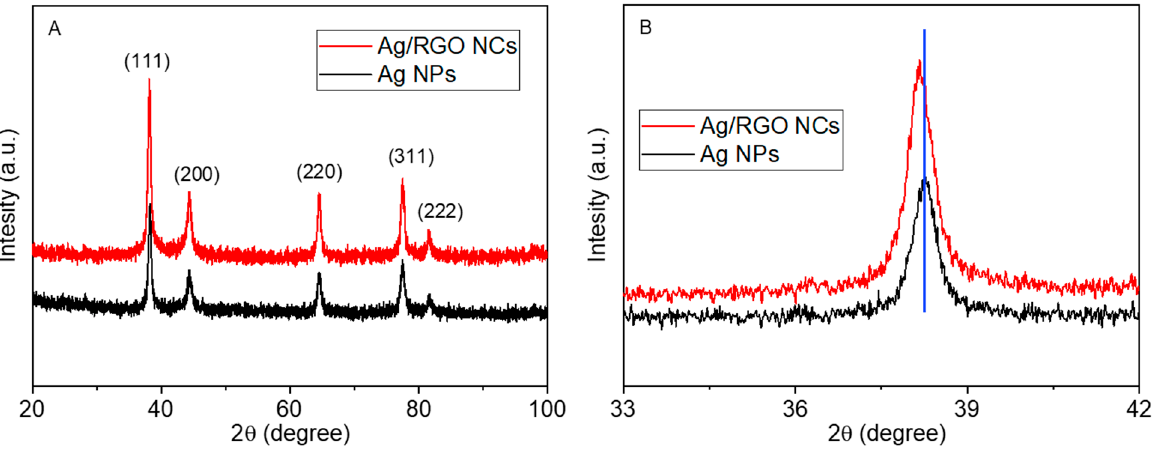
Figure 3. XRD characterization: ( A ) XRD spectra of Ag NPs and Ag/RGO NCs; ( B ) peak shifting.